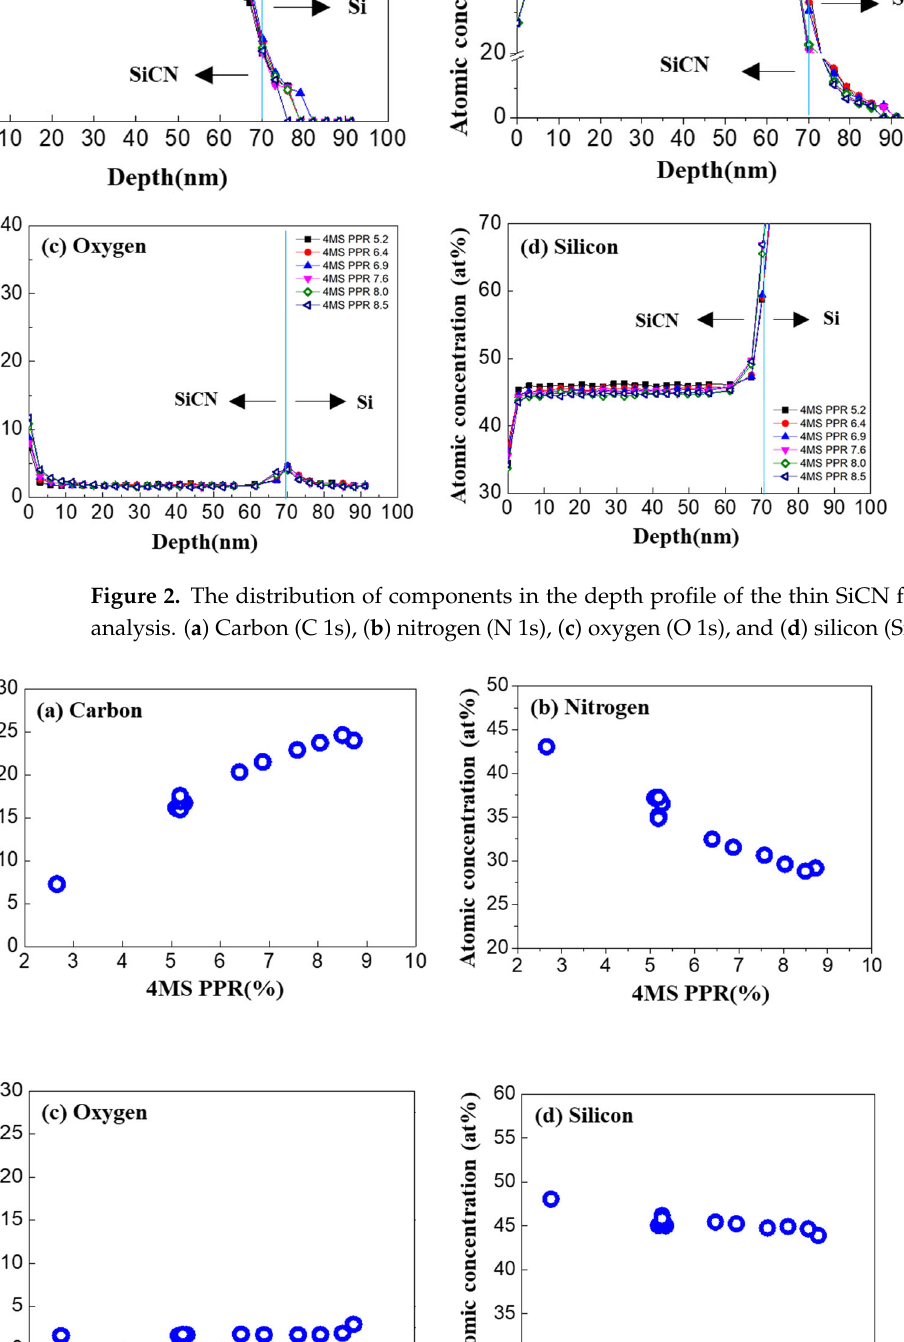
Figure 3. The composition ratio at the one ‐ fourth point of the SiCN thin film according to 4MS PPR. ( a ) Carbon, ( b ) nitrogen ( c ) oxygen, and ( d ) silicon. Additional experiments were conducted to confirm the trend of oxygen increase above 8.5% (Figure 3). As a result, it was confirmed that after the deposition of the thin film, the amount of oxygen increased above 8% of the 4MS PPR (Figure 4).